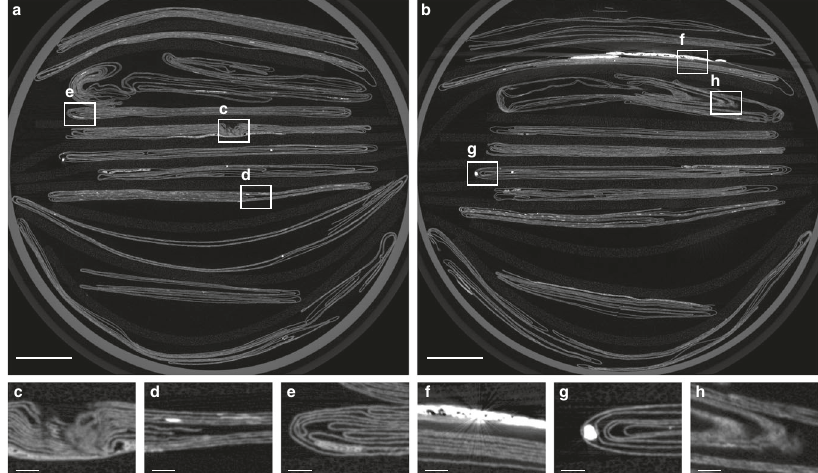
Fig. 3 XMT scans of 11 letterpackets. Two sample cross sections of XMT data at a z = 525 and b z = 1611, showing 11 letterpackets. From top to bottom, letter IDs are DB-1465, DB-1818, DB-2004, DB-1538, DB-1976, DB-1627, DB-2199, DB-2156, DB-1888, DB-2040, and DB-1876. Note that DB-1888 is not visible in cross section b . c – h Segmentation challenges associated with XMT data. c Paper layer compaction results in ambiguous boundaries between layers. Dense regions of d ink, e adhesive, f sealing wax, and g pounce sand (used to absorb ink) interfere with neighboring regions of scan. h Paper may be angled relative